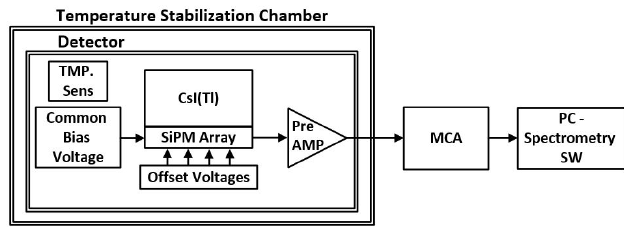
Fig. 8. Connection scheme of the detector and the measuring setup.